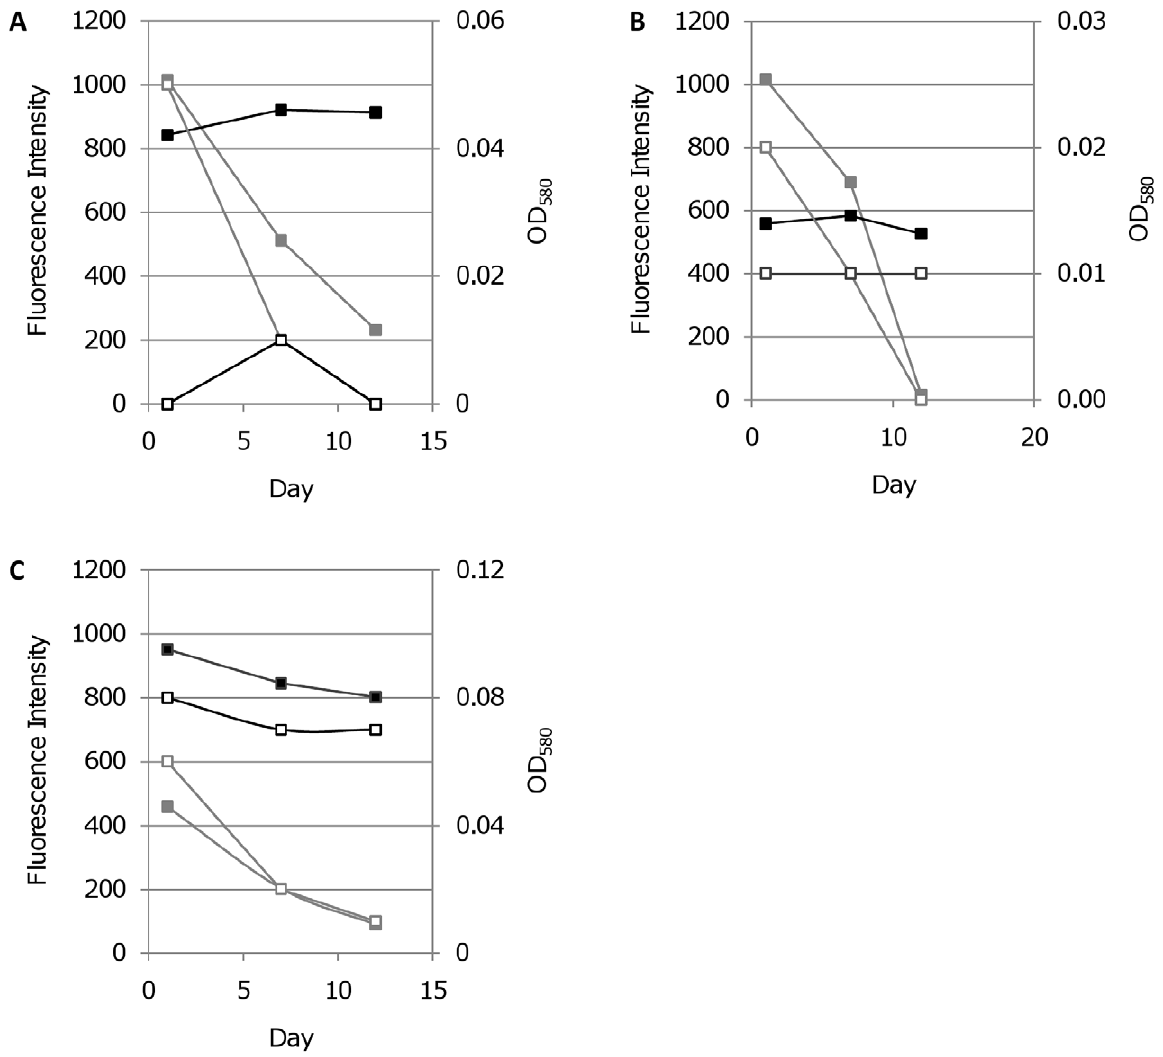
Figure 12. Correlation between cell viability and fluorescence in M.tuberculosis during antibiotic treatment. Transformants expressing FPs from P smyc were grown in liquid and treated with the bactericidal antibiotic kanamycin (grey line) or the static antibiotic chloramphenicol (black line). Fluorescence intensity (solid squares) and OD 580 (open squares) were measured. A. mCherry, B. tdTomato and C. Turbo-635.